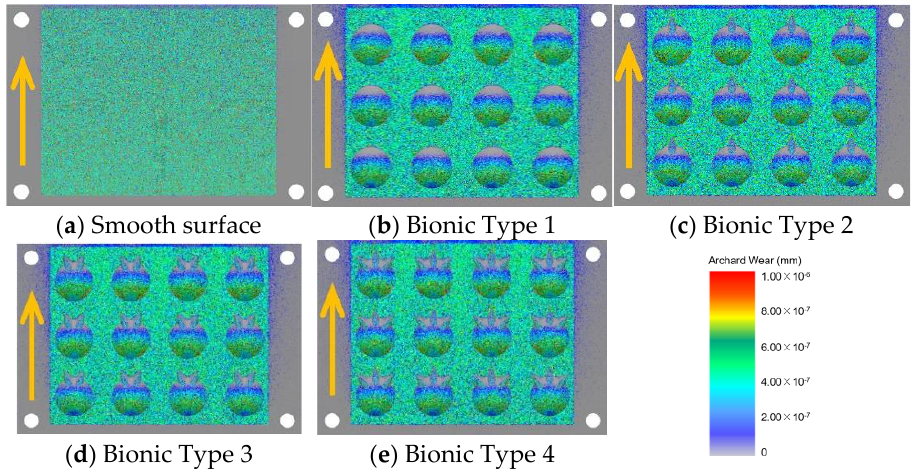
Figure 11. Cloud map of worn surface morphology (the direction of abrasive movement is indicated by the arrow).